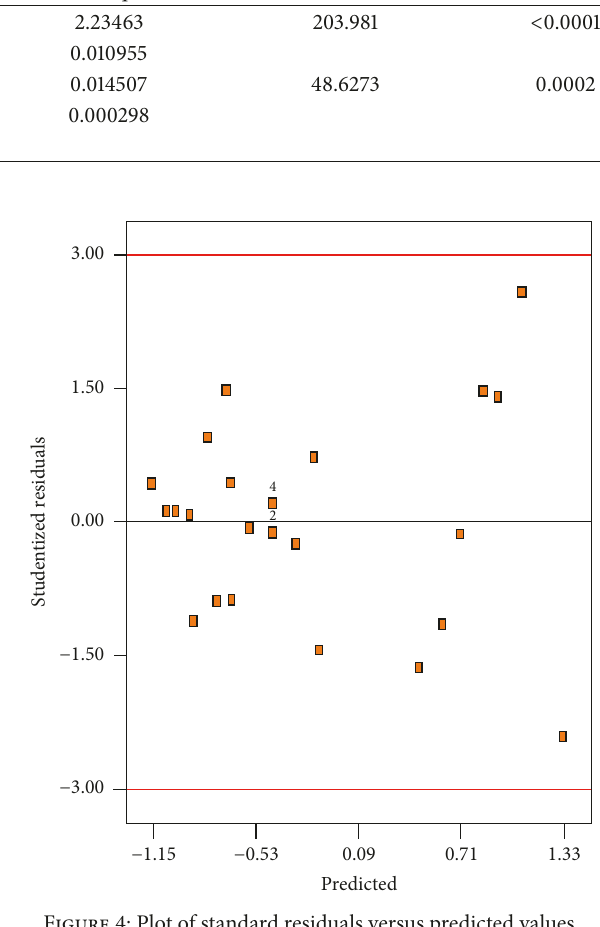
Figure 4: Plot of standard residuals versus predicted